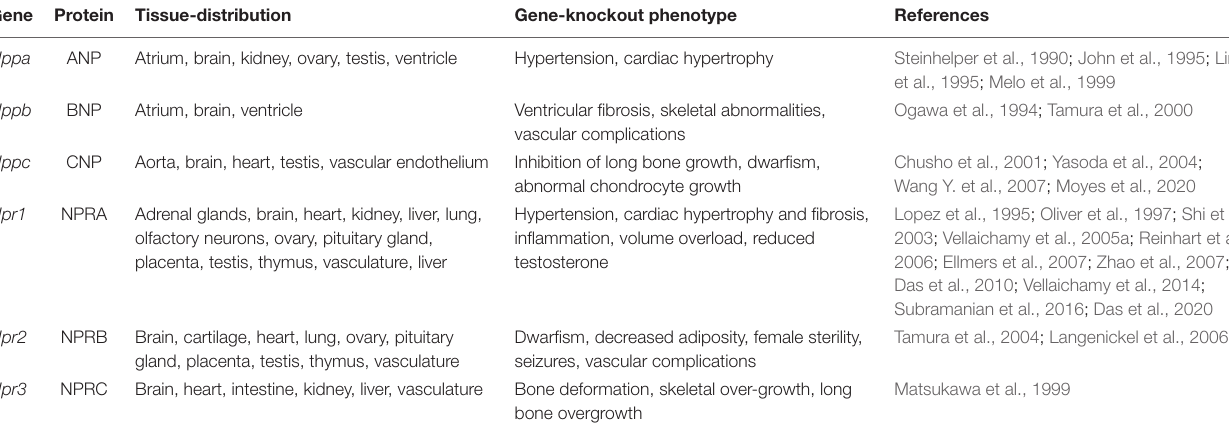
TABLE 1 | Tissue distribution of natriuretic peptides (ANP, BNP, and CNP) along with their cognate receptors (NPRA, NPRB, and NPRC) and gene-knockout phenotypes in mice. Gene Protein Tissue-distribution Gene-knockout